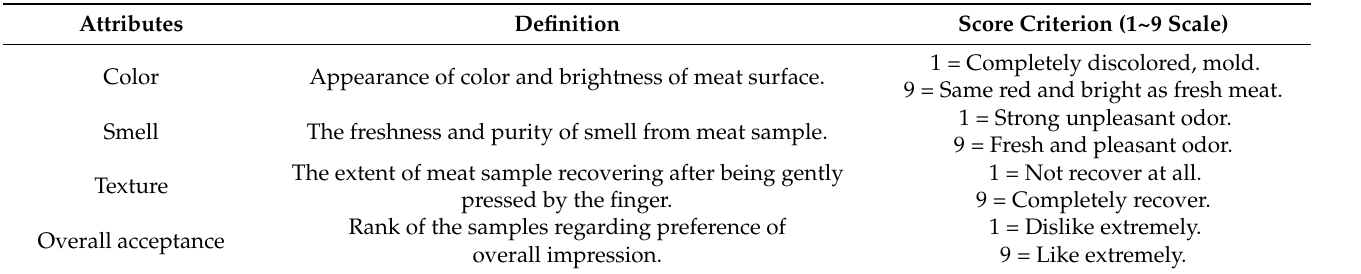
Table 1. Definition and score criterion of sensory quality